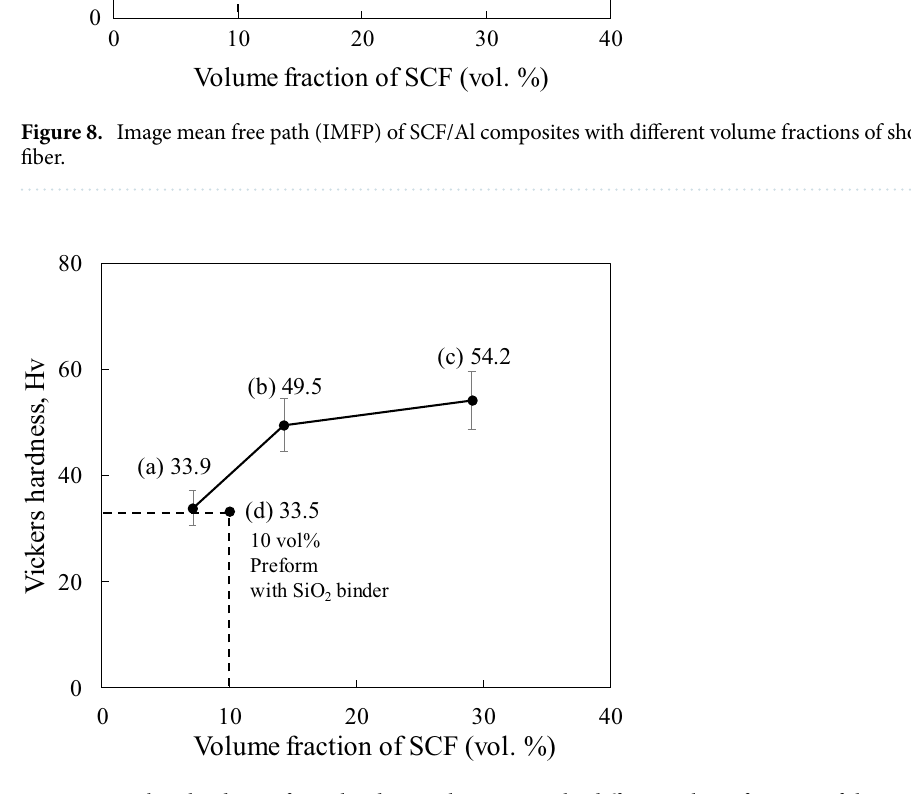
Figure 9. Vickers hardness of Cu-plated SCF/Al composites by different volume fractions of short carbon